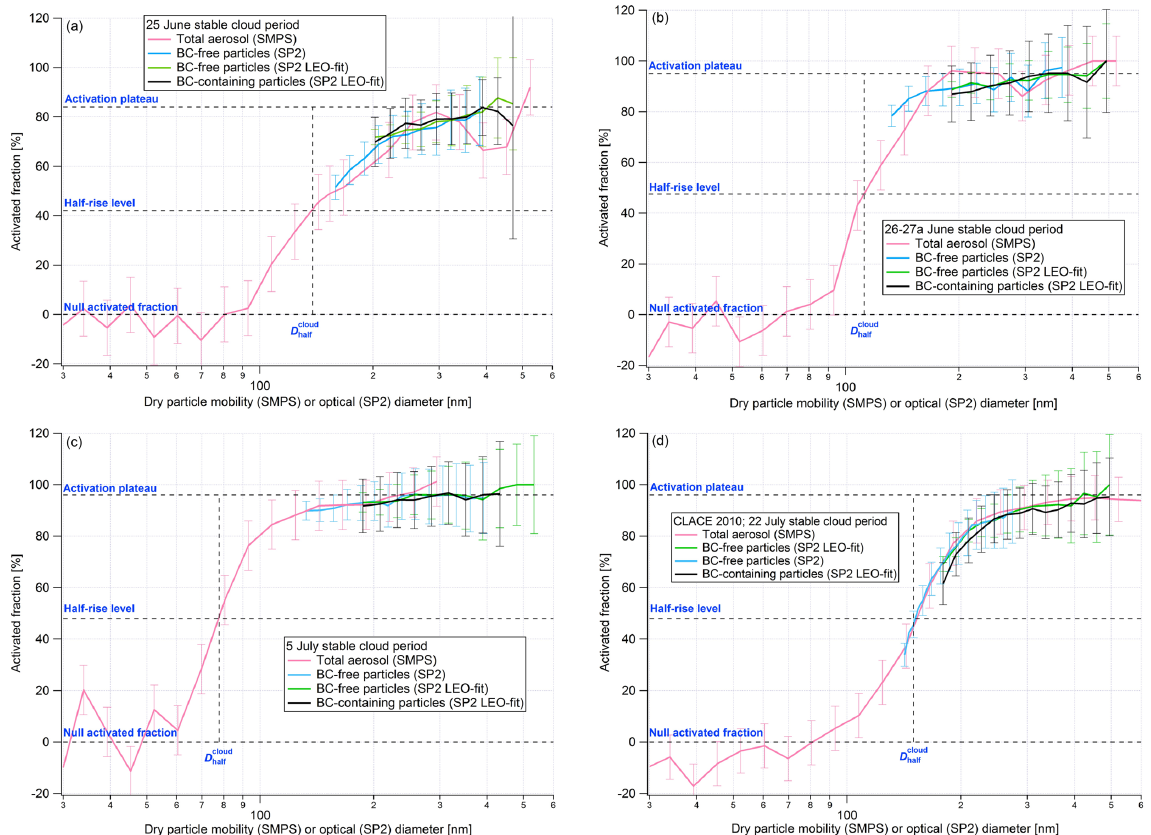
Figure 2. Fraction of particles that activated to cloud droplets as a function of particle dry diameter as derived from the measurements behind the total and interstitial inlets for four example cloud events (averaged over the complete stable period). SMPS-derived activated fractions are shown against mobility diameter and include all particles, whereas SP2-derived data are separately shown for BC-free and BC-containing particles, both against optical diameter. BC-free particles are shown against optical diameter determined with standard optical sizing and against optical diameter determined using the LEO-fit approach in order to confirm consistency between the two. Each panel shows a different cloud event. The vertical dashed line marks the SMPS-derived half-rise threshold diameter for activation. Note that these activation spectra are averaged over a duration of 36 to 54min, which may have resulted in a smearing of the activation transition if the cut-off diameter varied slightly in